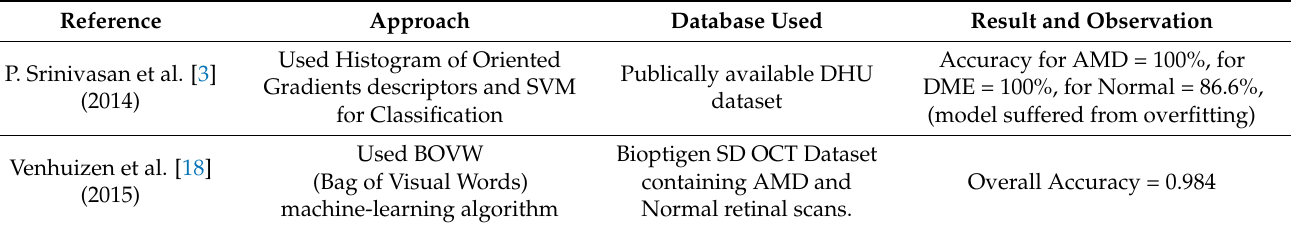
Table 3. Comparative analysis of retinal disease